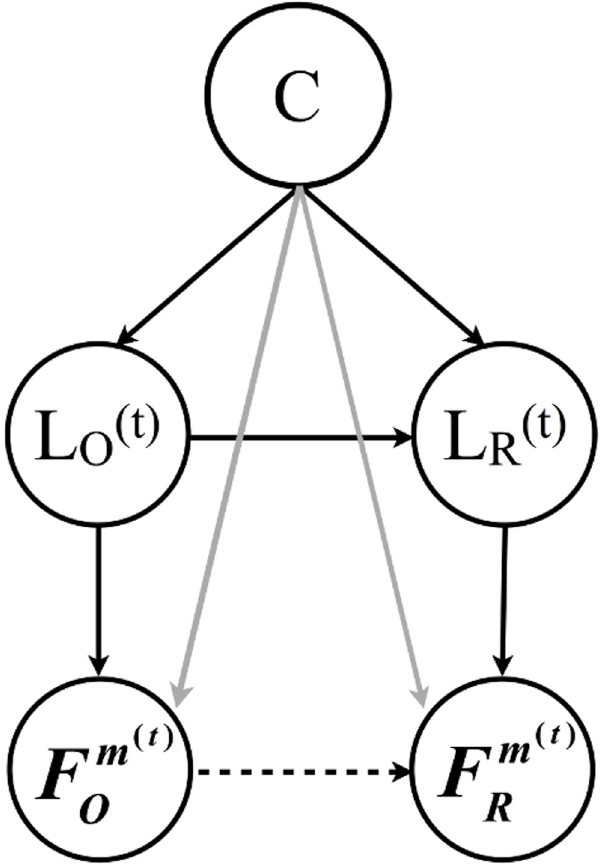
Fig 5. A Bayesian network for linguistic style coordination. L O and L R represent length of the respondent and length of the originator respectively. F m O and F m R represent a speci fi c style feature variable for the respondent and